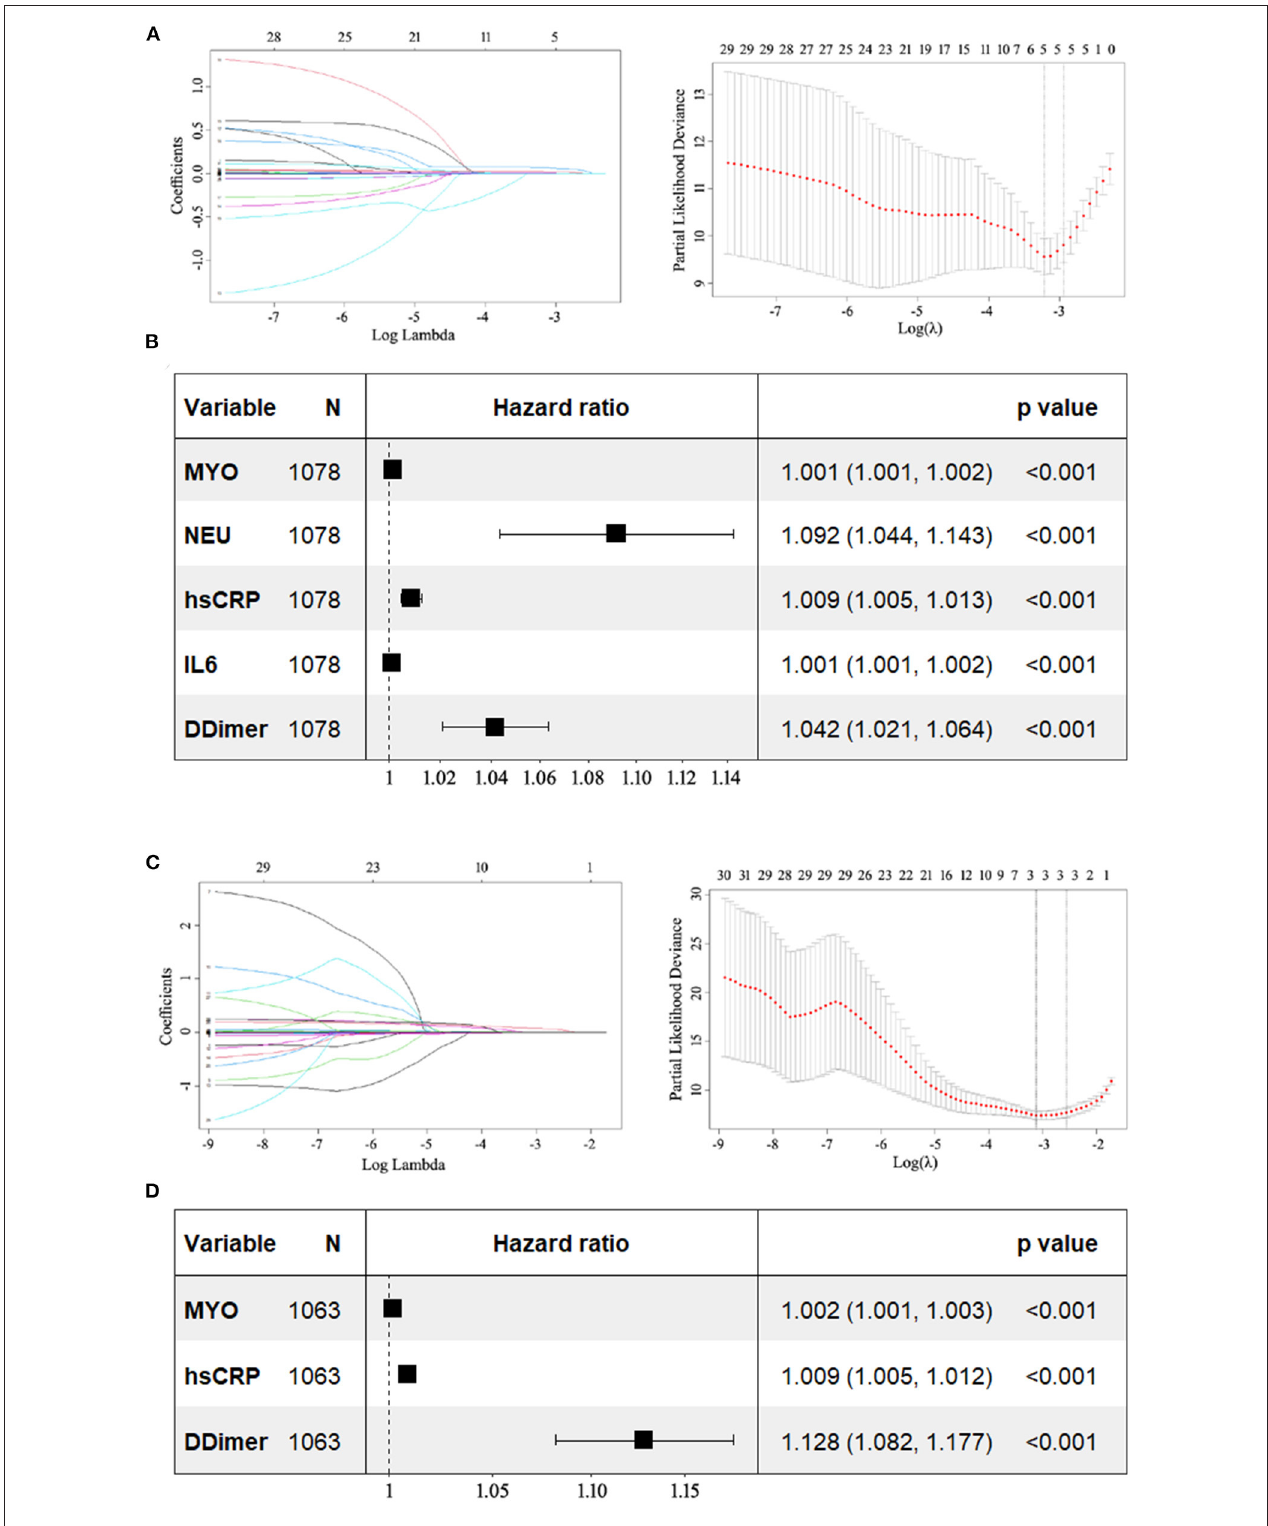
FIGURE 4 | Forest plots showing the results of multivariate Cox analysis. The potential prognostic factors included in the multivariate analysis were previously identified by LASSO regression. (A) LASSO coefficient profiles of the 30 variables including age, sex, comorbidities, physical examinations, and early-stage results